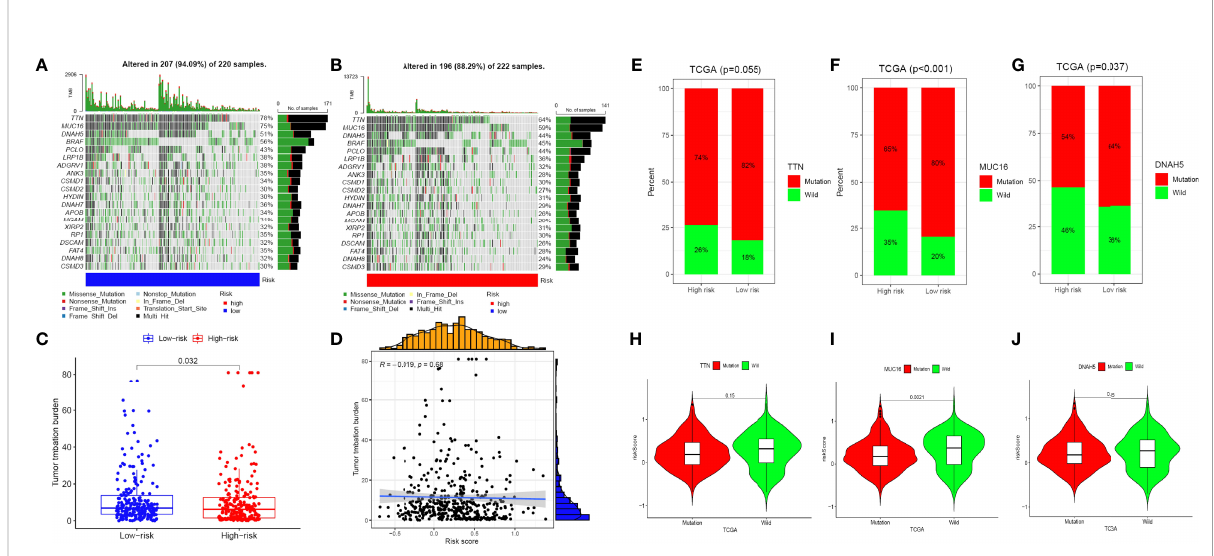
FIGURE 7 The mutation pro fi le and TMB among low-risk and high-risk groups. (A, B) Mutation pro fi le of low-risk and high-risk groups. (C, D) The relationship between the immune-related risk signature and TMB. (E – G) The proportion of mutation of TTN, MUC16 and DNAH5 in both low-/ high-risk groups form the TCGA-SKCM dataset. (H – J) Comparison of the risk score between mutation and wild groups.(ns, not signi fi cant, *P < 0.05, **P < 0.01, and ***P <